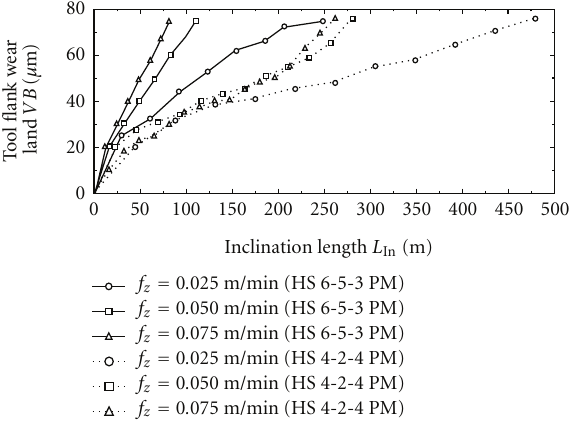
Figure 15: Influence of varied work piece material and the inclination cutting length on the tool flank wear